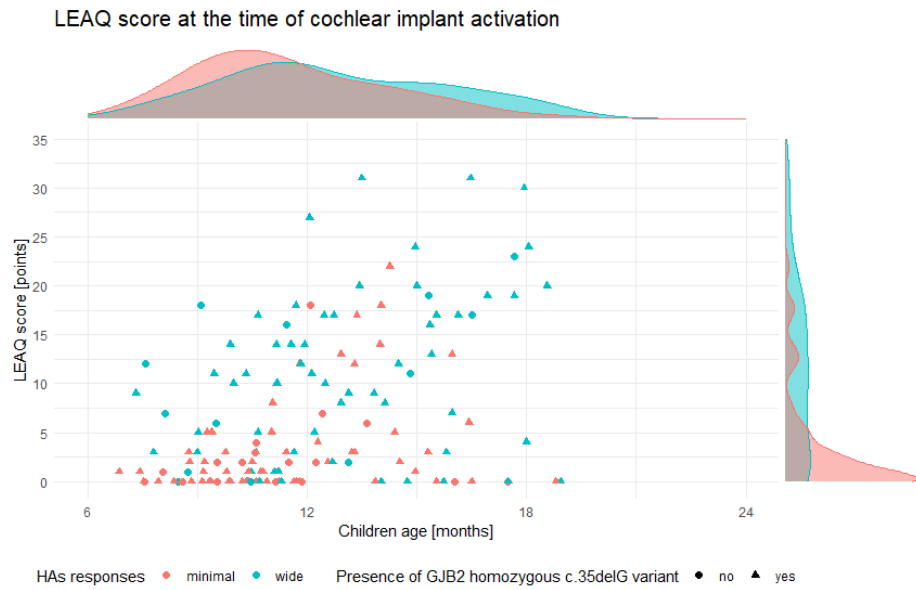
Figure 2. Distribution of LEAQ scores at the time of cochlear implant activation in DFNB1 HL patients.